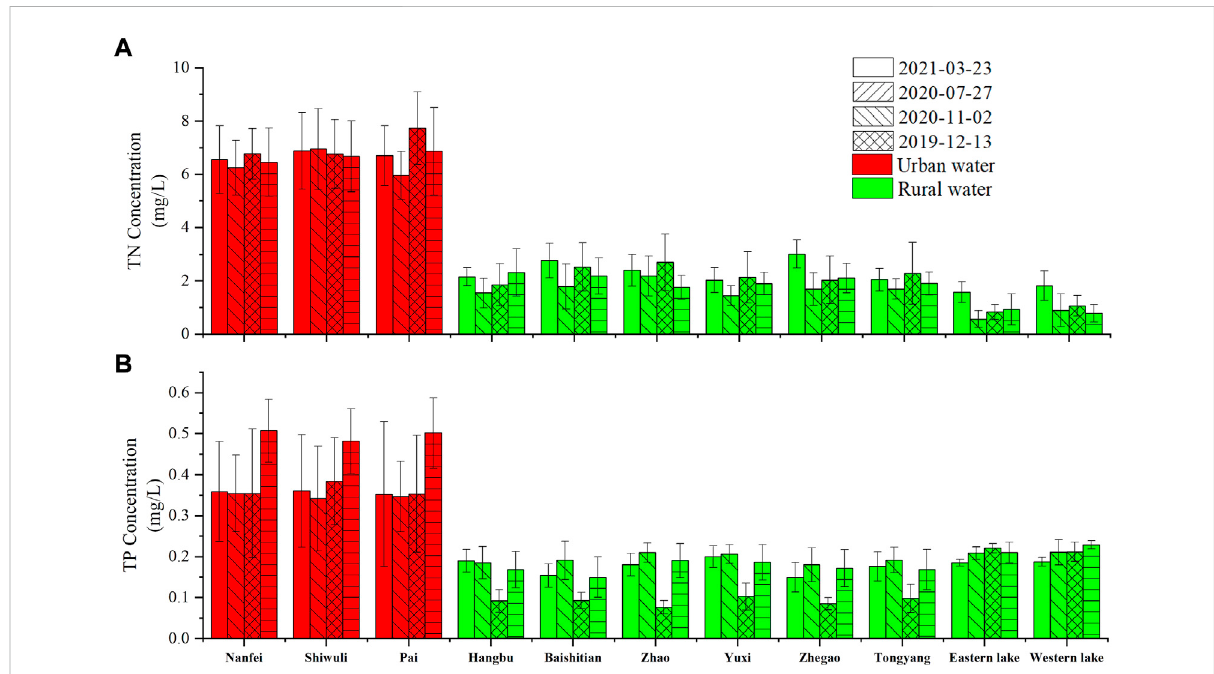
FIGURE 7 Inner-annual variation of the retrieved TN/TP concentration in the water around Chaohu Lake. (A) TN concentration; (B) TP concentration.